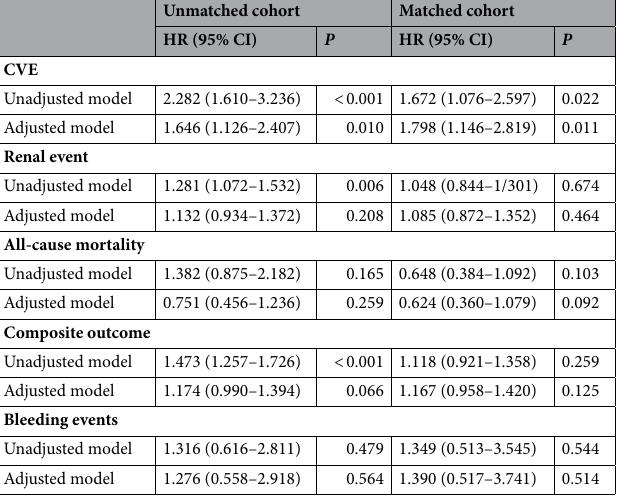
Table 2. Multivariate Cox proportional analyses for clinical outcomes a . Adjusted for age, male gender, BMI, smoking, baseline eGFR, previous CVD, diabetes, hypertension, proteinuria, hemoglobin, albumin and total cholesterol levels, and use of medications (RAAS blockers, CCB, beta-blockers, statin, warfarin, and other antiplatelet agents. HR hazards ratio, CI confidence